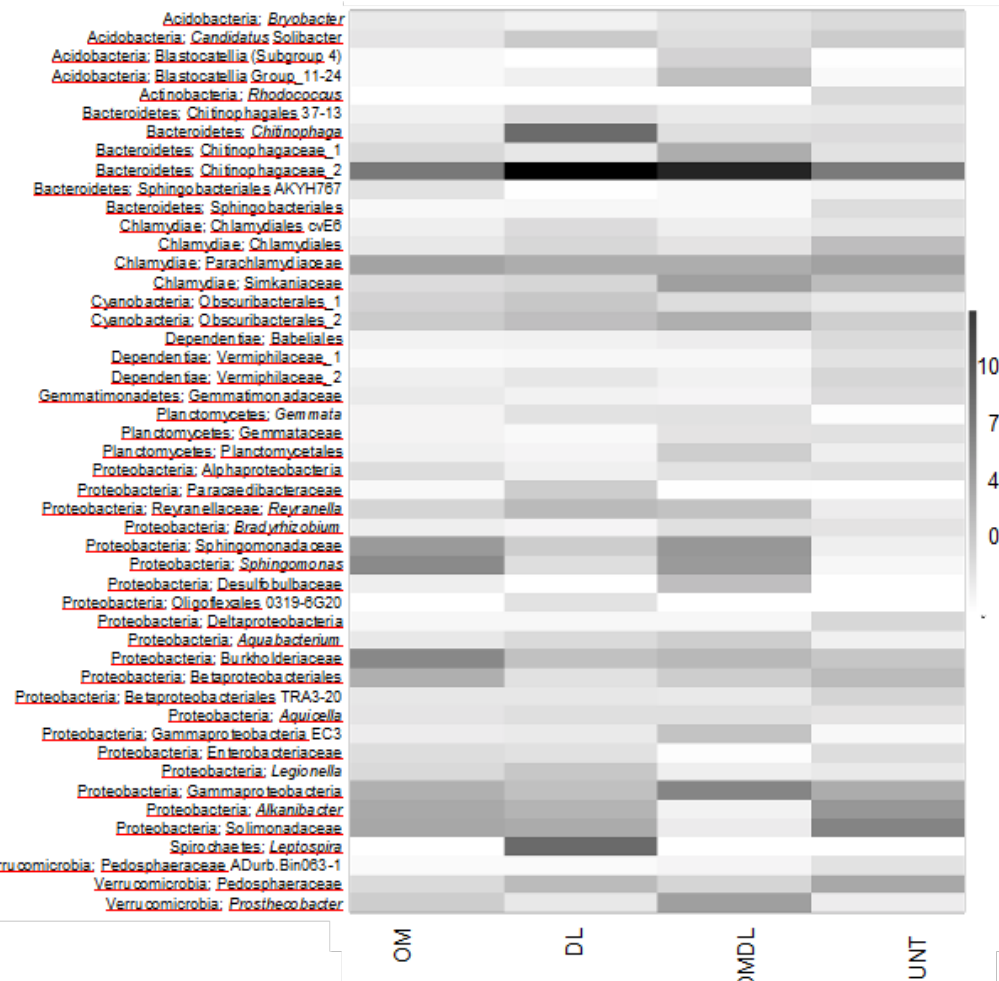
Figure 3. Heatmap prokaryotic operational taxonomic units (OTUs) at genus level with relative abundance > 1% of the total sequences detected in at least one treatment replicate revealed by the analysis of the 16S rRNA gene using high throughput sequencing.